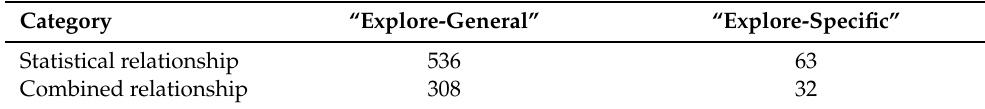
Table 6. The average node degree of retrieval results for “health” with two different relationships.